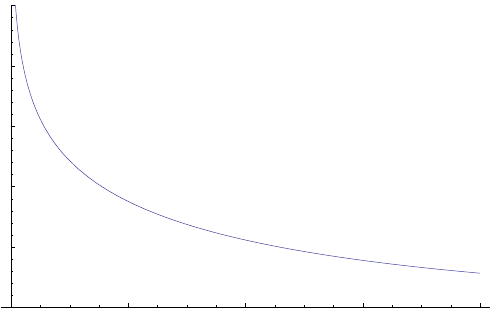
Figure 8 . K 0 ( x ) is a monotonically decreasing function.